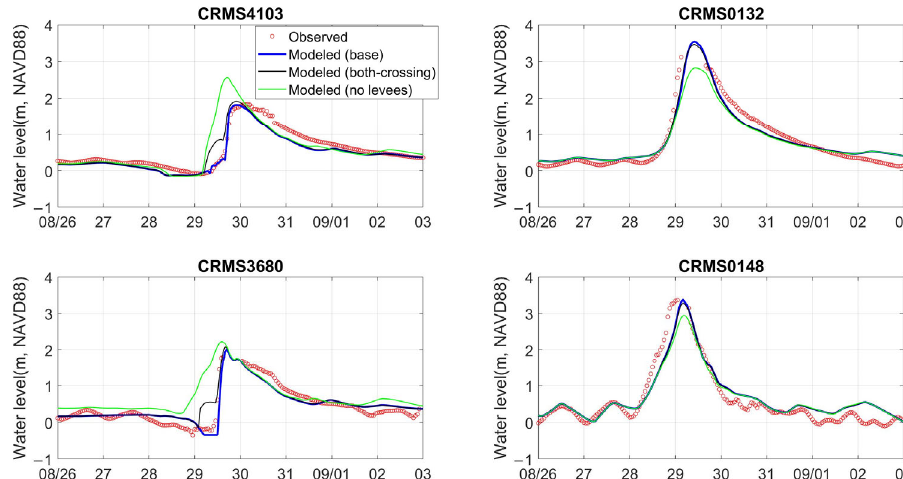
Figure 4. Comparisons of water level (m, NAVD88) time series between the observed (red circle) and the modeled phenomena in three scenarios (blue line for the base case, black line for the both-crossing case and green line for the no-levee case) at four CRMS stations during Hurricane Isaac (2012).